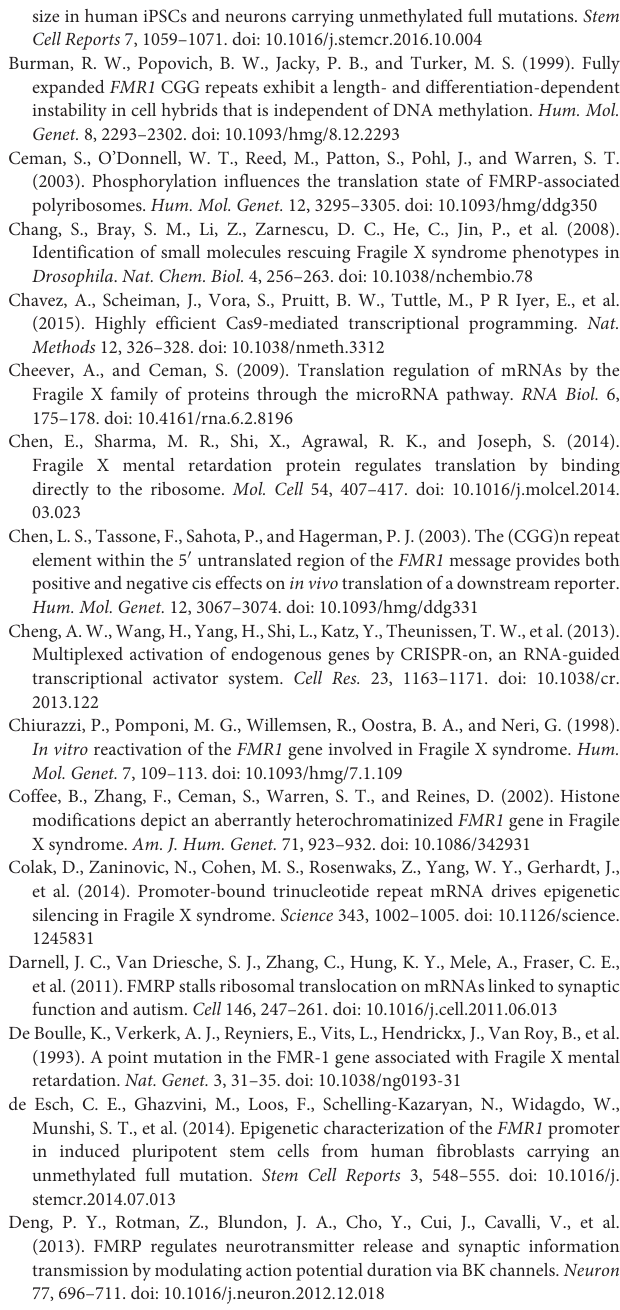
FIGURE S1 | Gene ontology analysis and pathways for WT vs. late FXS hESCs. (A) Graph depicting top Gene Ontology (GO) terms for the RNA-seq data comparing WT and FXS hESCs. X -axis shows the GO terms and Y -axis shows the negative log (base 10) of the p -values for each category. (B) All pathways from the WT and FXS hESC RNA-seq analysis are plotted in terms of the two